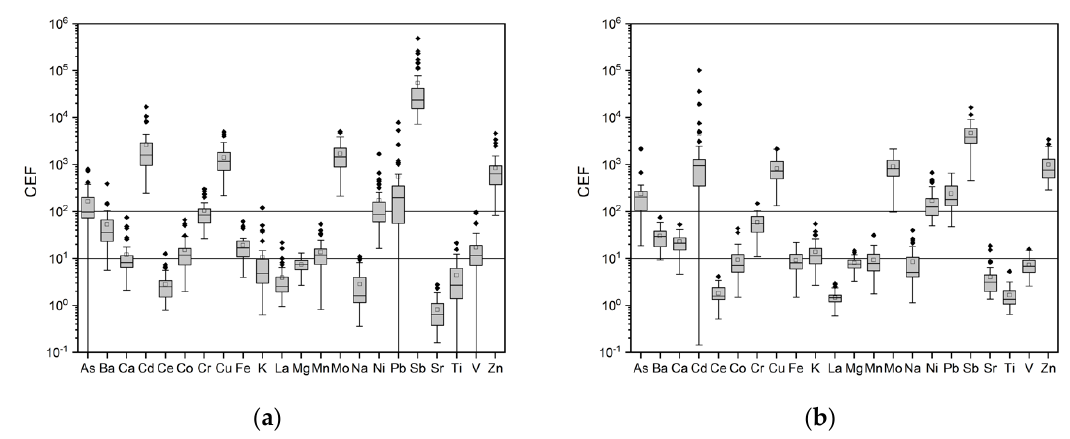
Figure 3. Box plots of crustal enrichment factors (CEFs) calculated with respect to the upper crust composition reported by Wedepohl [43] for ( a ) 2012 samples; ( b ) 2014 samples.